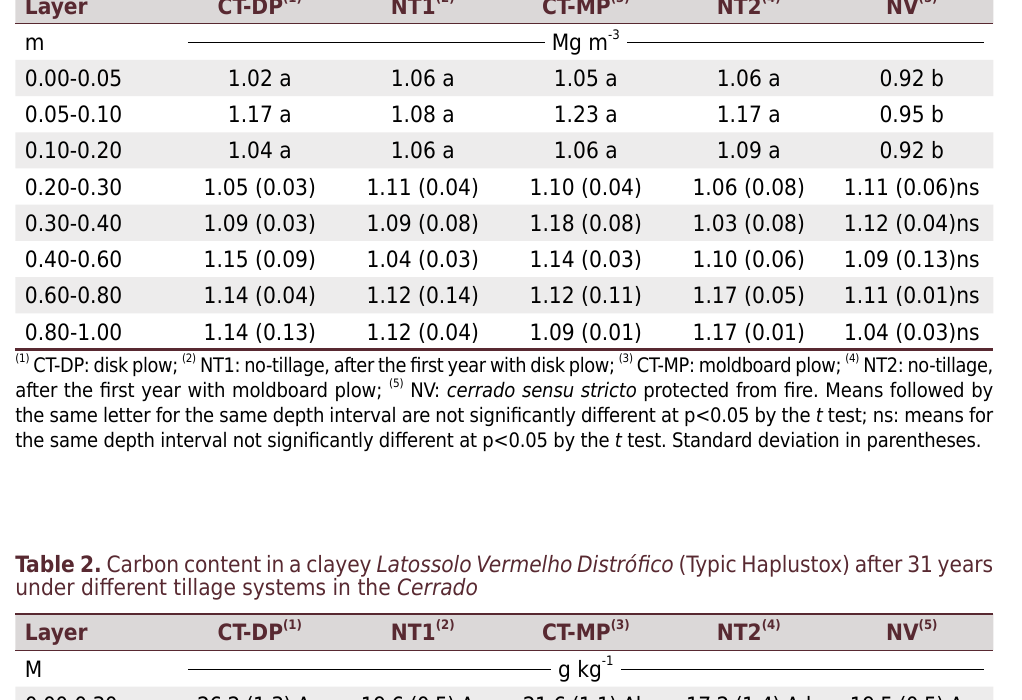
Table 1. Soil bulk density of a clayey Latossolo Vermelho Distrófico (Typic Haplustox) in the 0.00-1.00 m depth range under different management systems in the Cerrado Layer CT-DP (1) NT1 (2) CT-MP (3)